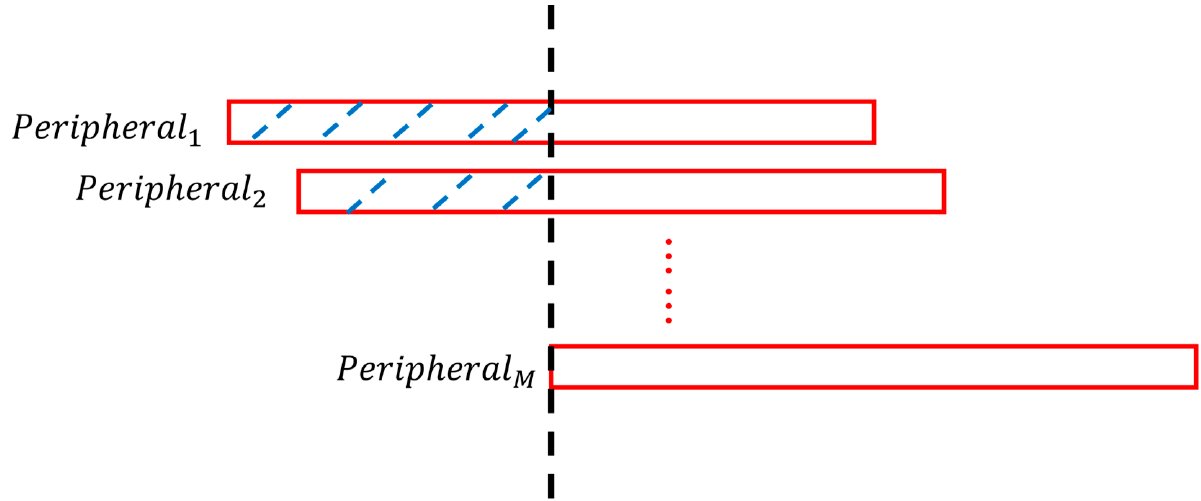
Figure 1. Aligning the 𝑀 peripheral nodes at startup. Red blocks represent the data packet streams. The black dashed line marks the arrival of the last peripheral into the configuration, signifying the start time of the whole system. Blue dashed lines mark discarded ADC data samples.